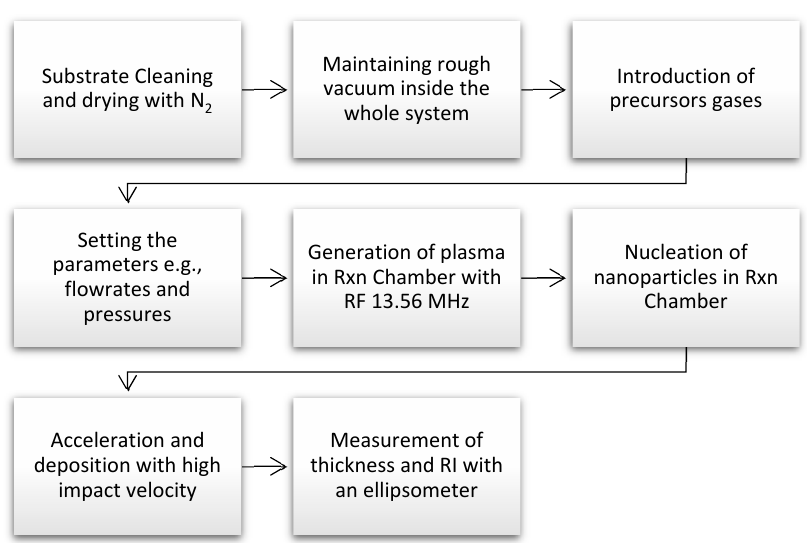
Figure 2. Experimental steps.